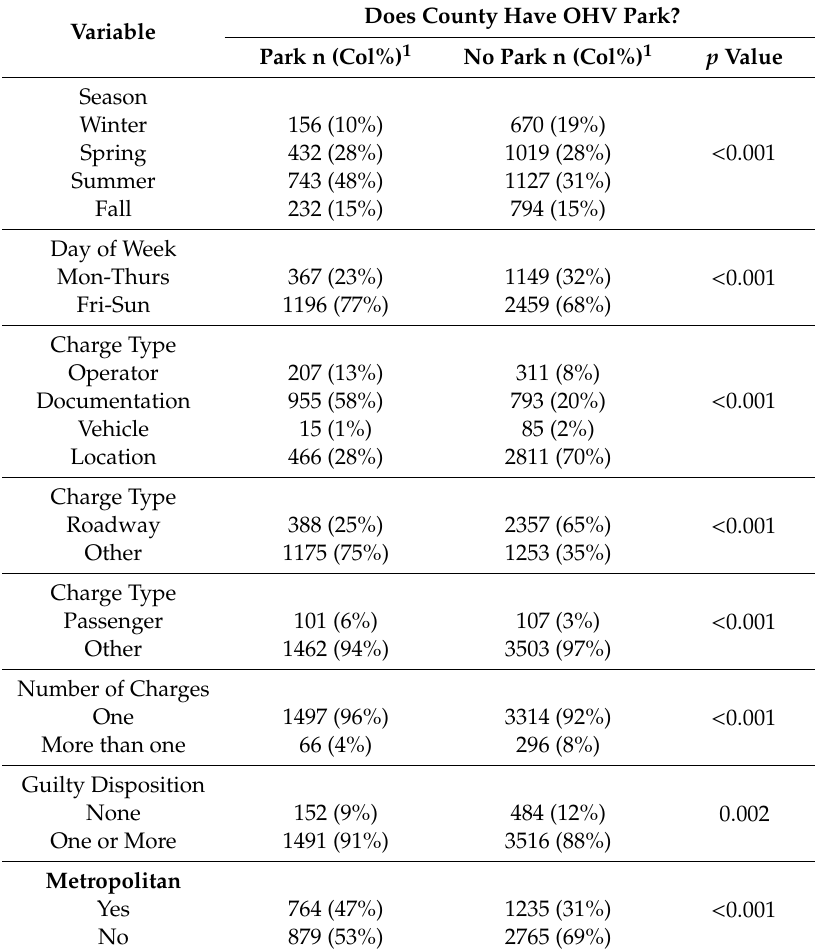
Table 5. Comparisons for counties with and without an o ff -highway vehicle (OHV) park for o ff -road vehicle (ORV) citations in the Iowa Courts Information System (ICIS) from